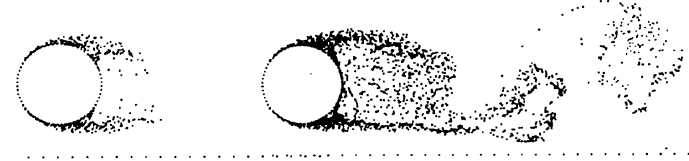
Figure 4. Vortex shedding frequency vs. wall distances. Figure 5. The flow pattern at 𝑡̂ = 1 and 5 at G/D = 0.5.